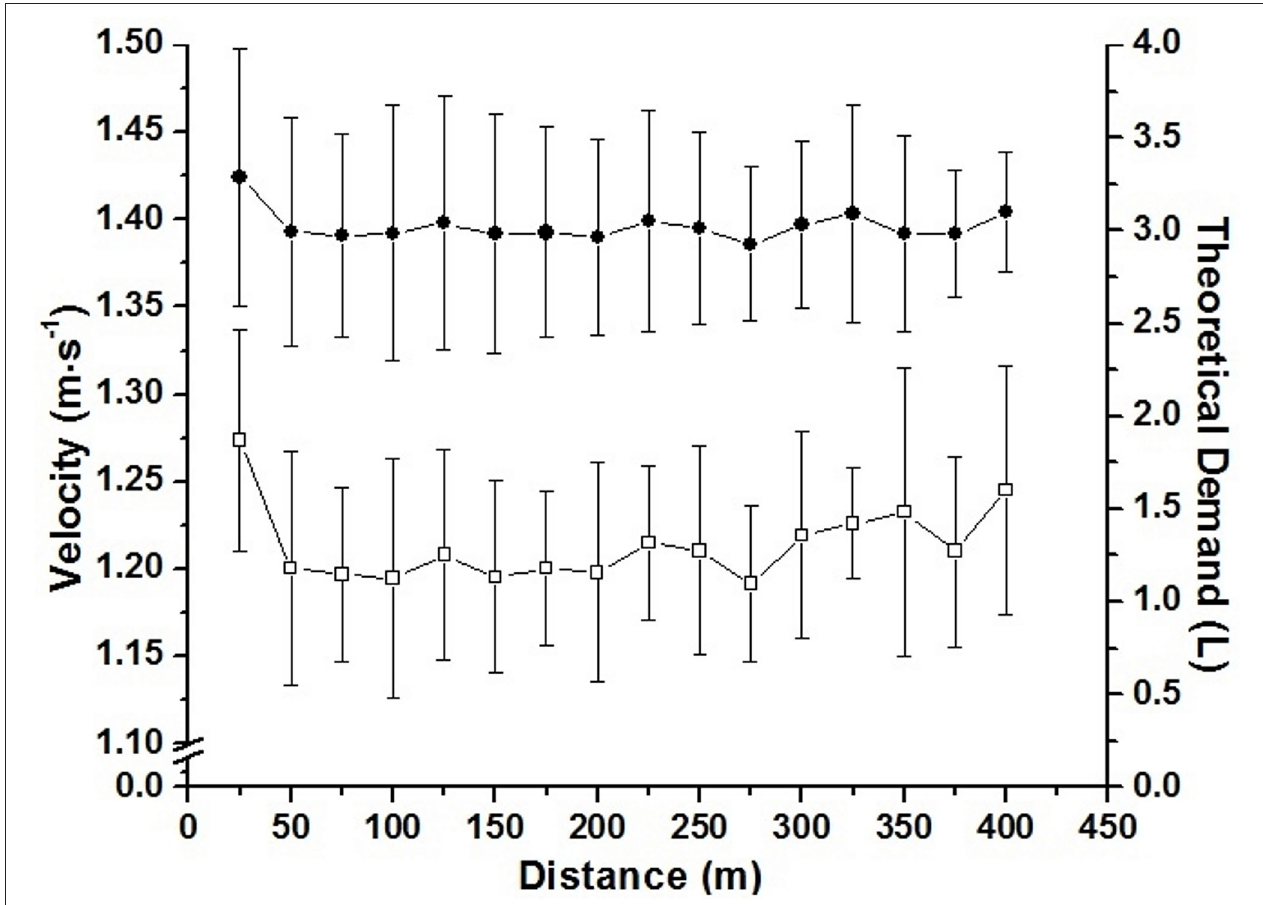
FIGURE 3 | Mean and standard deviation for speed during the 400m partial ( 2 ; left axis), and estimated demand calculated for each 25m portion (•; right